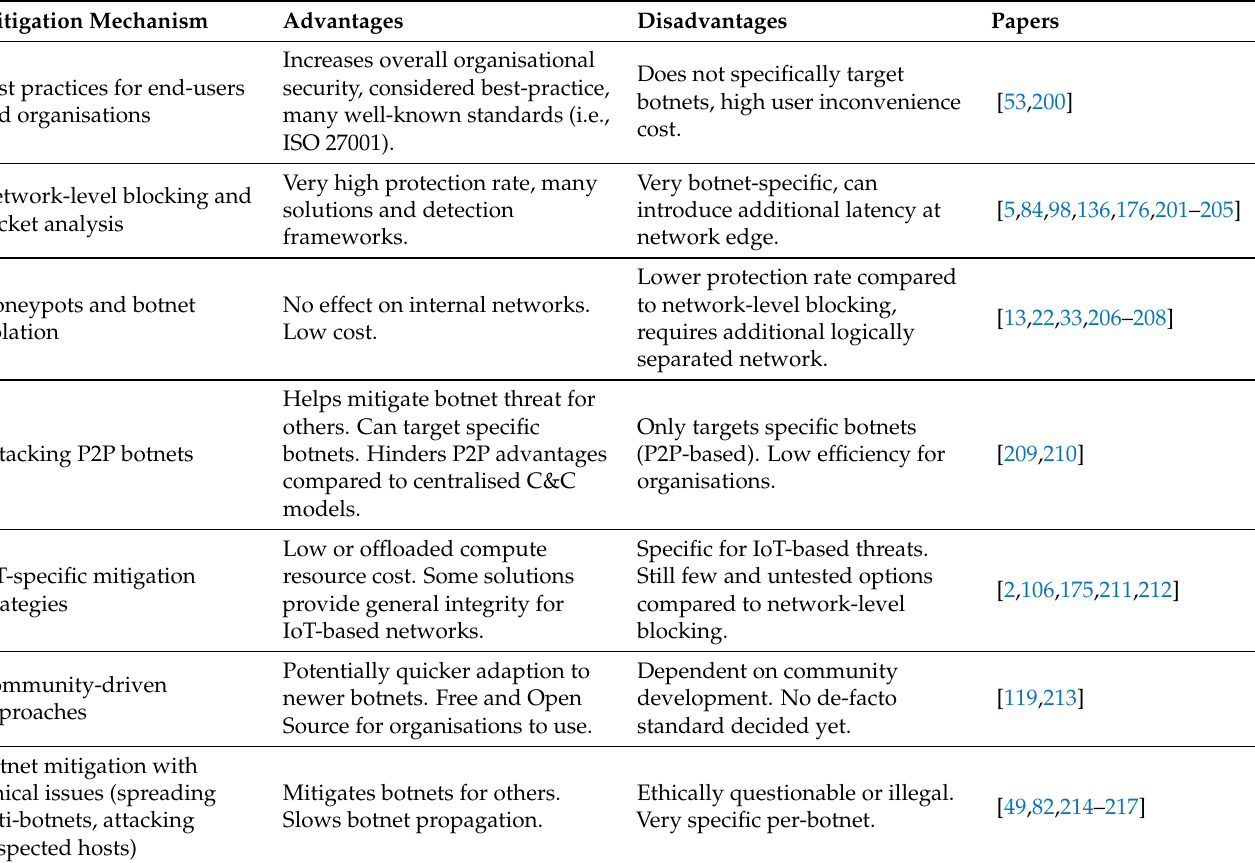
Table 9. This table details the specific mitigation methods described in the following section, the advantages and disadvan- tages, as well as associated